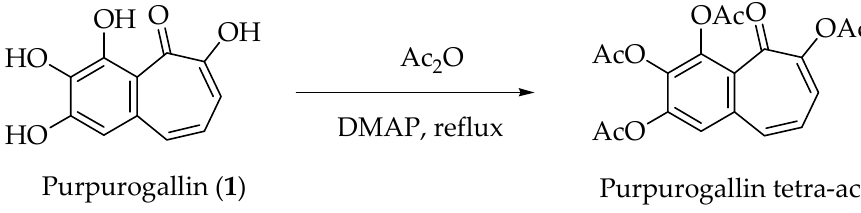
Scheme 1. Acetylation of purpurogallin.